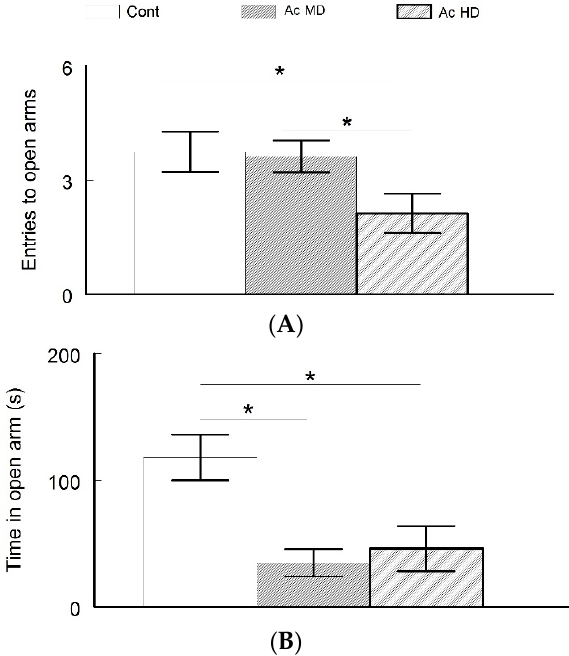
Figure 3. ( A , B ) Elevated plus maze test to assess anxiety. Although the Ac MD group (3.6 ± 0.42 s) entered the open arms more frequently than the Ac HD group (2.13 ± 0.52) ( A ), it spent the least amount of time in the open arms (34.9 ± 10.8) ( B ). Overall, the caffeine-treated mice were more anxious than the control group. Asterisks mark significant differences between the groups.